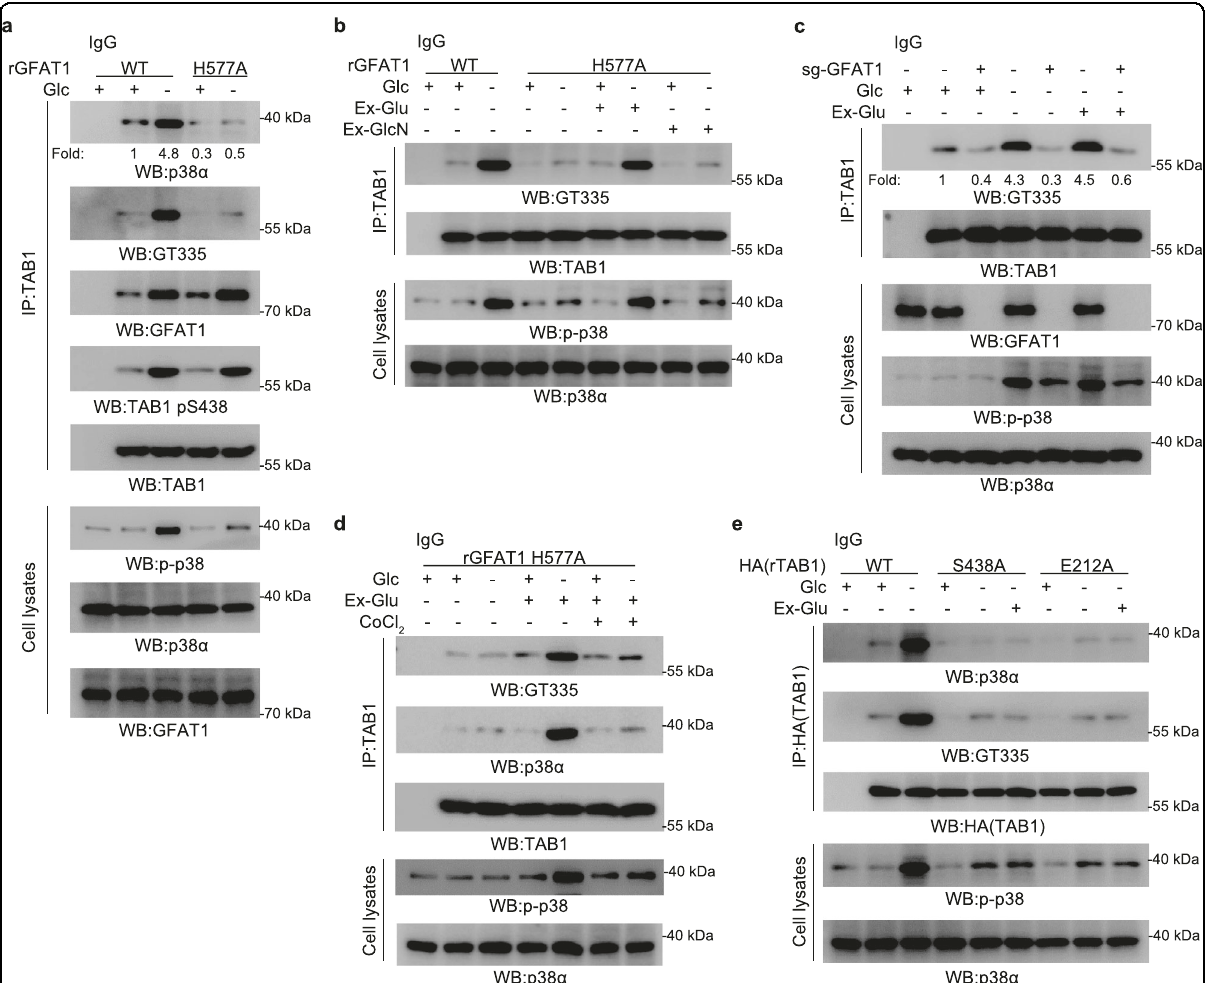
Fig. 4 Glutamate derived from GFAT1 is required for TAB1 glutamylation. a Expression of rGFAT1-H577A inhibited TAB1 glutamylation and TAB1 – p38 interaction. A549 cells with deleted GFAT1 and reconstituted expression of WT rGFAT1 or rGFAT1-H577A were cultured for 8 h under glucose deprivation. Immunoprecipitation and immunoblotting analyses were performed using the indicated antibodies. b Exogenous glutamate rescued TAB1 glutamylation in rGFAT1-H577A-expressing cells. A549 cells with deleted GFAT1 and reconstituted expression of WT rGFAT1 or rGFAT1- H577A were cultured for 8 h under glucose deprivation with exogenous glutamate (Ex-Glu) or glucosamine (Ex-GlcN). Immunoprecipitation and immunoblotting analyses were performed using the indicated antibodies. c Exogenous glutamate failed to rescue TAB1 glutamylation in GFAT1- deleted cells. A549 cells with or without deleted GFAT1 were cultured for 8 h under glucose deprivation with exogenous glutamate (Ex-Glu). Immunoprecipitation and immunoblotting analyses were performed using the indicated antibodies. d CoCl 2 inhibited TAB1 glutamylation rescued by exogenous glutamate in rGFAT1-H577A-expressing cells. A549 cells with deleted GFAT1 and reconstituted expression of rGFAT1-H577A were cultured for 8 h under glucose deprivation with exogenous glutamate (Ex-Glu) and CoCl 2 (10 μ M). Immunoprecipitation and immunoblotting analyses were performed using the indicated antibodies. e Exogenous glutamate failed to rescue TAB1 glutamylation in rTAB1-S438A- or rTAB1- E212A-expressing cells. A549 cells with depleted TAB1 and reconstituted expression of WT rTAB1, rTAB1-S438A or rTAB1-E212A were cultured under glucose deprivation with exogenous glutamate (Ex-Glu). Immunoprecipitation and immunoblotting analyses were performed using the indicated